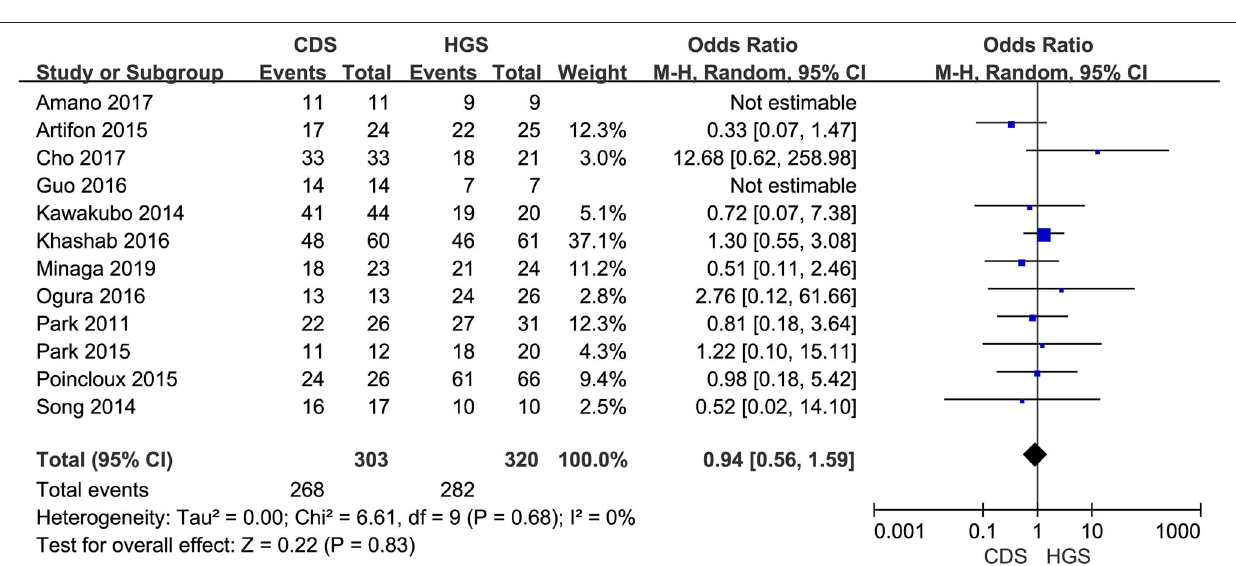
FIGURE 3 | Forest plot of clinical success between EUS-CDS and